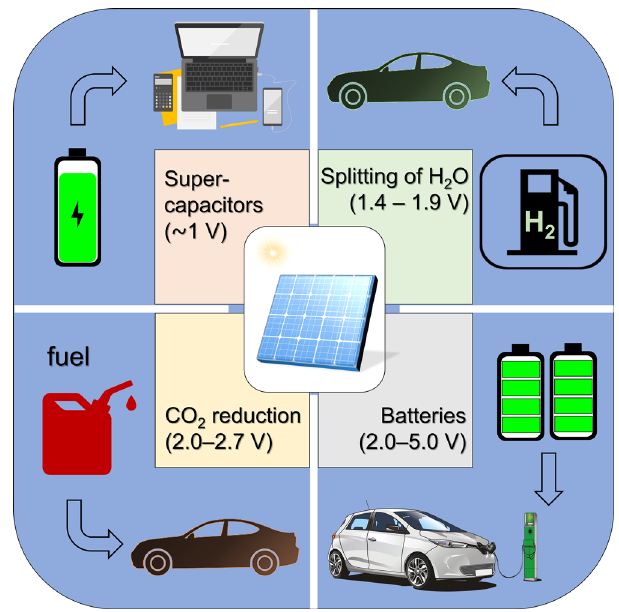
Fig. 9 Schematic illustration of PV-integrated energy storage systems and PV-cell-driven catalysis. Integrated PV and energy storage devices or catalysis systems. The overpotential windows required to drive different solar energy conversion and storage, particularly supercapacitors, water splitting, CO 2 reduction, are provided. It should be noted that the voltage outputs required to drive these systems vary depending on the performance of the electrode materials and